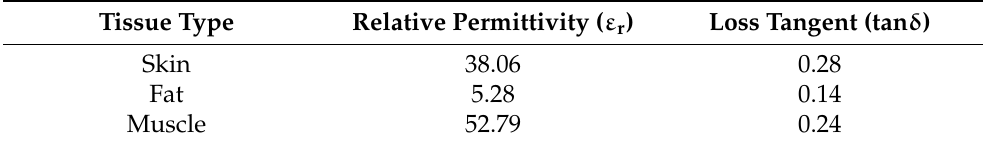
Figure 7. Simulated reflection coefficient for the Minkowski pre-fractal-shaped PIFA in air and placed on the human body. Table 1. Dielectric Properties of Body Tissue.